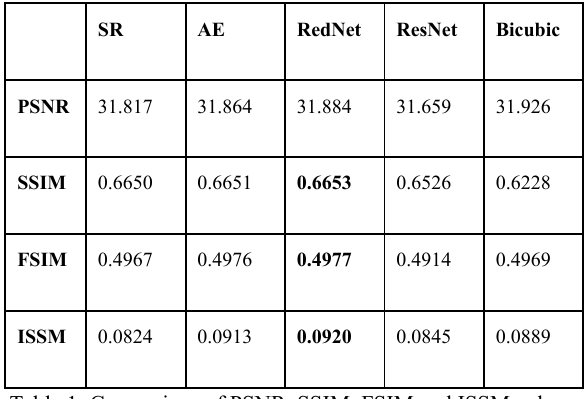
Table 1: Comparison of PSNR, SSIM, FSIM and ISSM values for the four implemented models and bicubic interpolation. In bold the value indicating the best performing